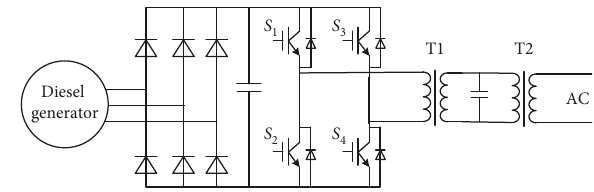
Figure 2: Shipboard power supply circuit of marine